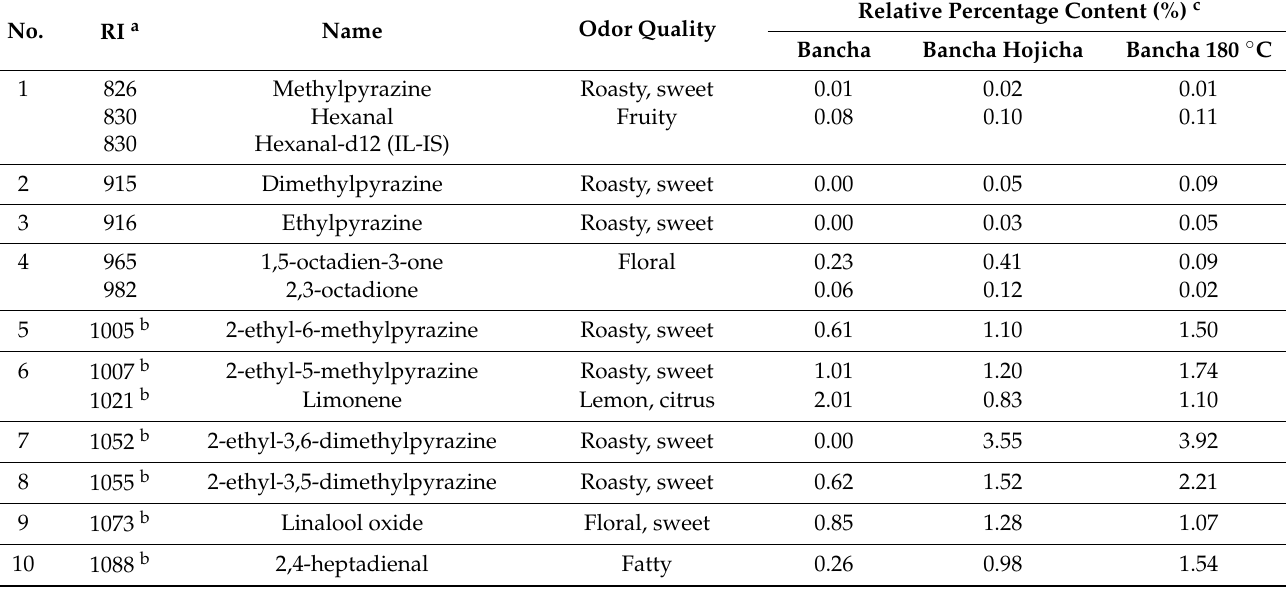
Table 2. Linear retention index (RI), odor quality and relative percentage of key odorants in representative green teas: Bancha, Bancha Hojicha and roasted Bancha green tea (180 ◦